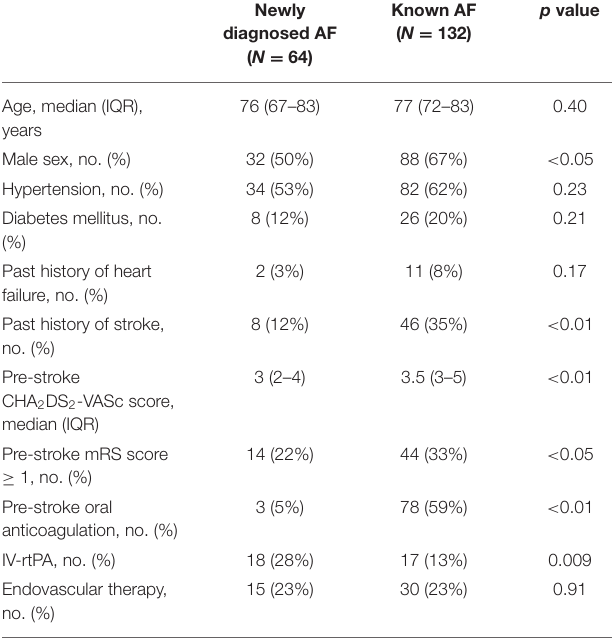
( Supplementary Table 1 ). Patients with mRS scores ≤ 2 at